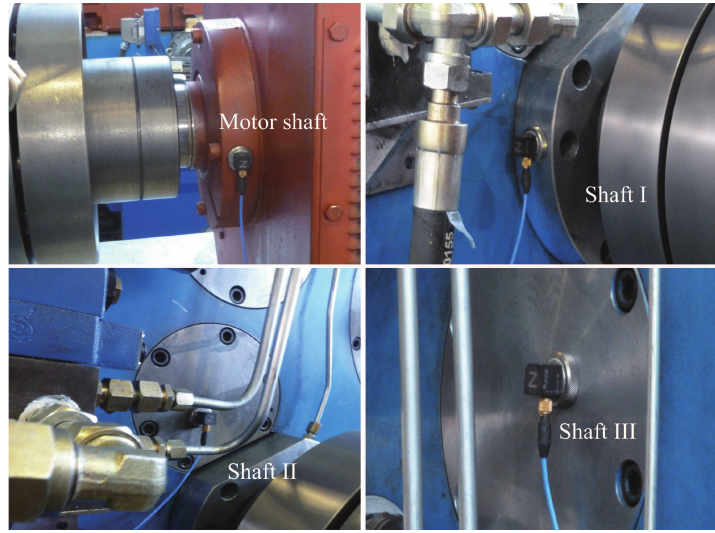
Figure 6. The layout of the sensor when measuring each